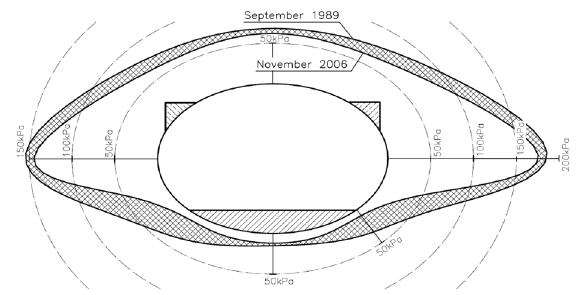
Figure 11: Changes in normal interactions in the course of service life of soil-steel structure